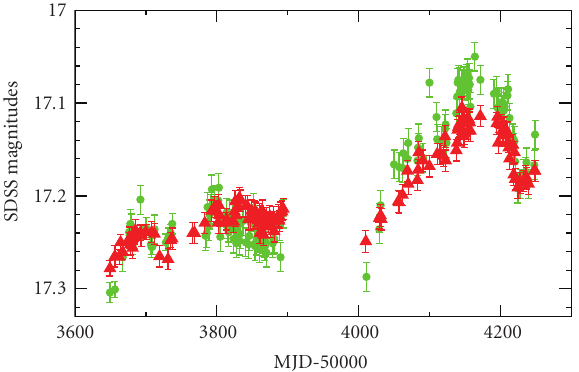
Figure 3: LRT light curves of QSO 0957 + 561A from October 2005 to June 2007. The r -band (red triangles) and g -band (green circles) curves are compared with each other. To make the comparison easier, the r -band magnitudes are shifted by +0.229